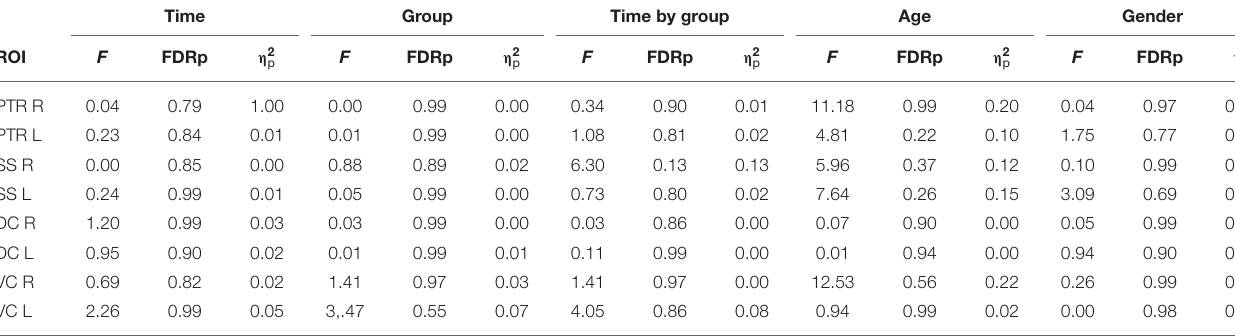
TABLE 2 | Repeated measures ANOVA results for mean FA in OCD patients ( n = 26) and healthy controls ( n = 22). Time Group Time by group Age Gender ROI